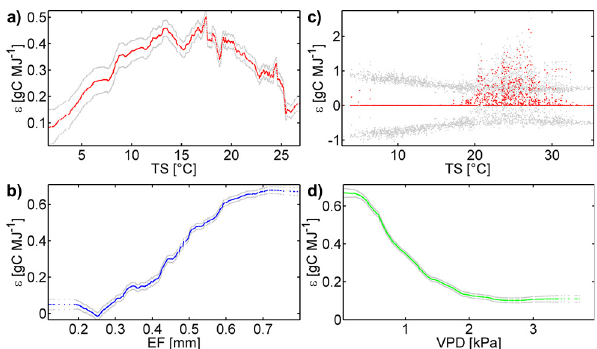
Fig. 5. (cid:15) as function of T S and EF at the Mediterranean site Roc- carespampani (a, b) and as function of T S and VPD at the desert- grassland Audubon (c, d) as determined by the additive SDP regres- sion (Eq. 12). The grey error bounds represent the standard errors of the SDP